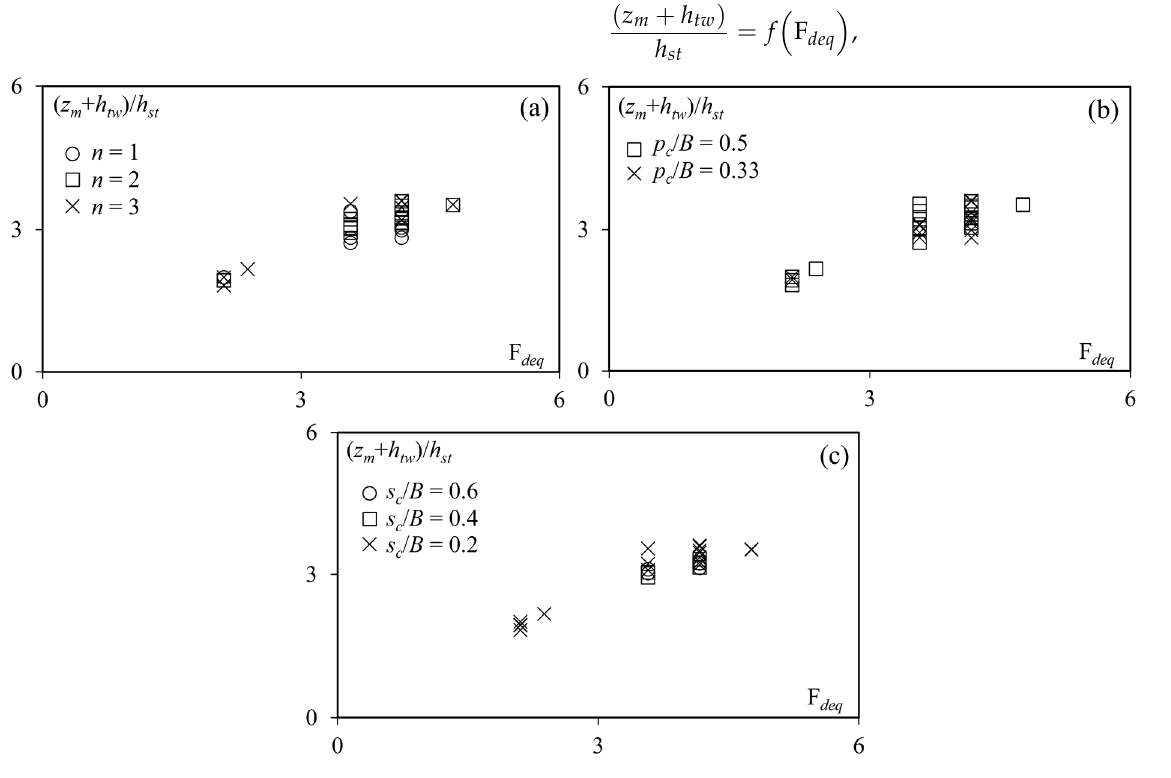
Figure 8. ( z m + h tw )/ h st vs F deq for different values of ( a ) n , ( b ) p c / B and ( c ) s c / B .